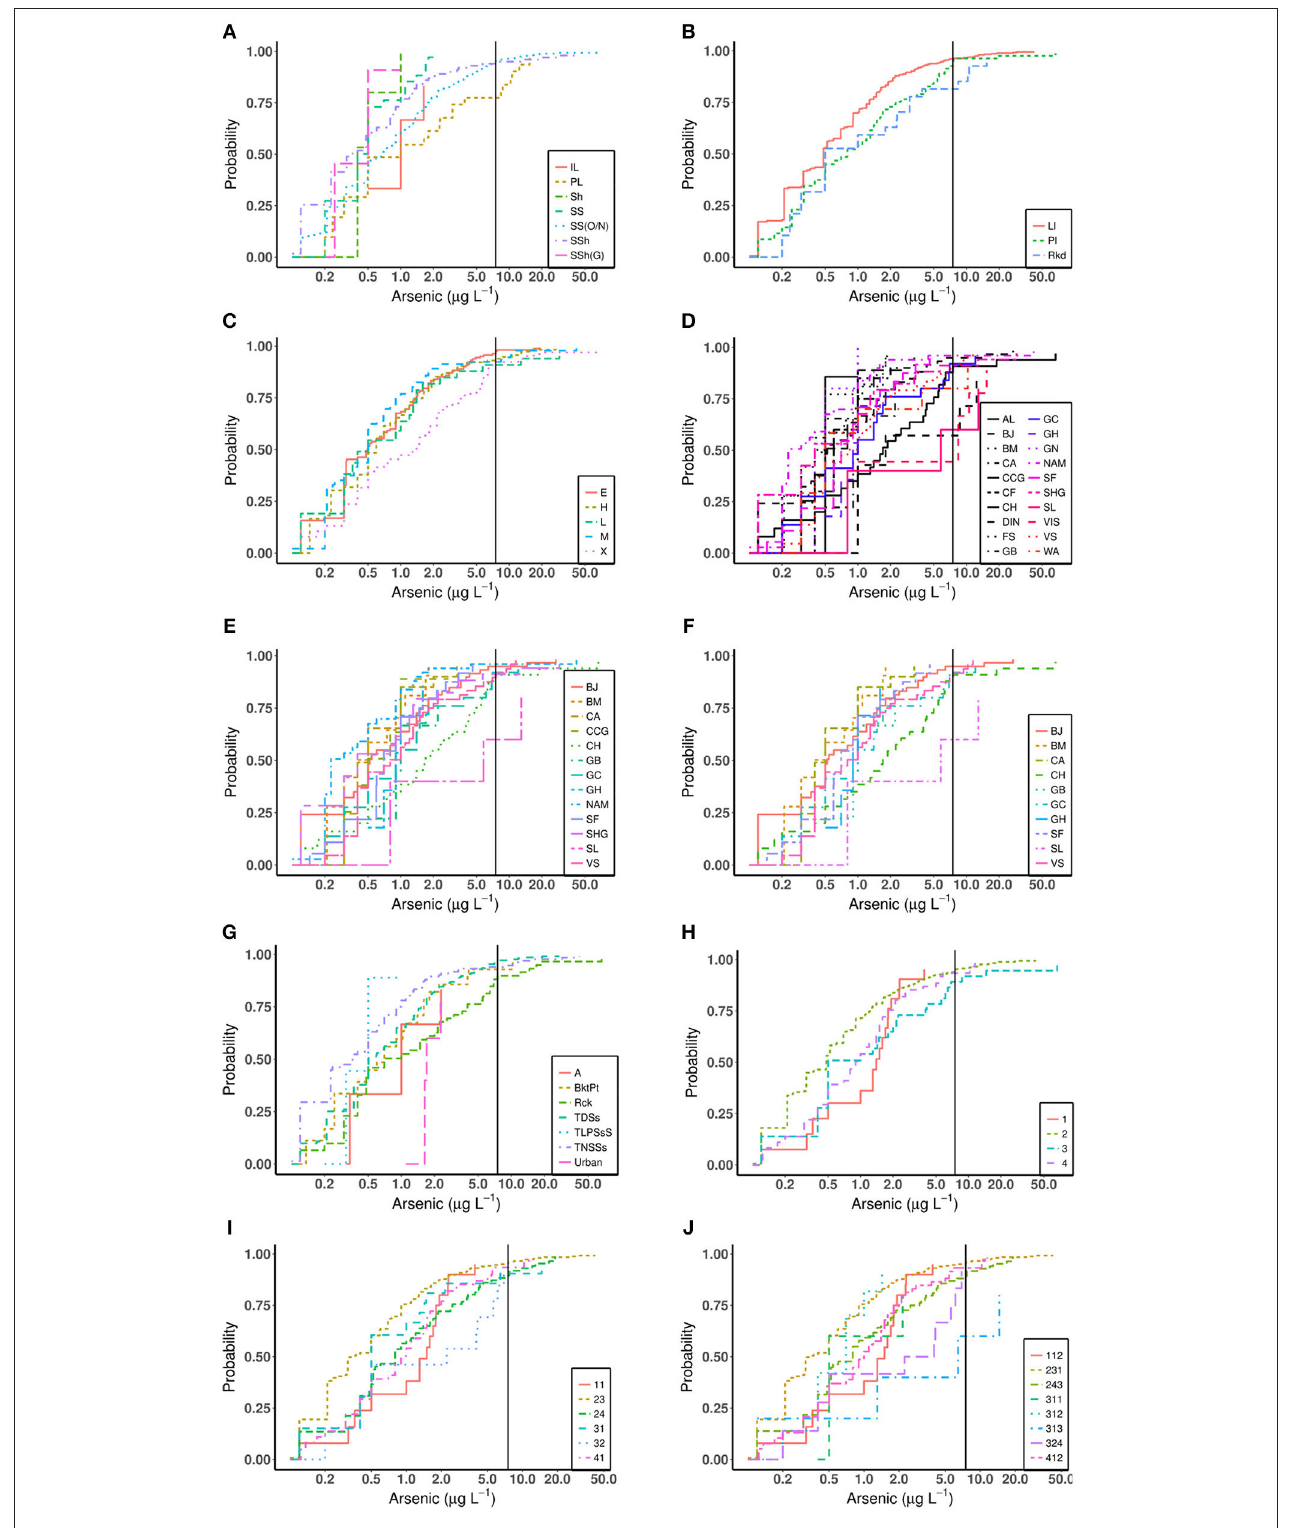
FIGURE 5 | ECDF plot displaying the empirical distribution function of arsenic in relation to (A) rock type, (B) aquifer, (C) groundwater vulnerability, (D) rock, (E) rock (SS(ON) and SSH), (F) rock (SS(ON) and SS), (G) quaternary, (H) CORINE(L1), (I) CORINE(L2), and (J) CORINE(L3). The arsenic GTV value of 7.5 µ g L − 1 is represented as a black vertical